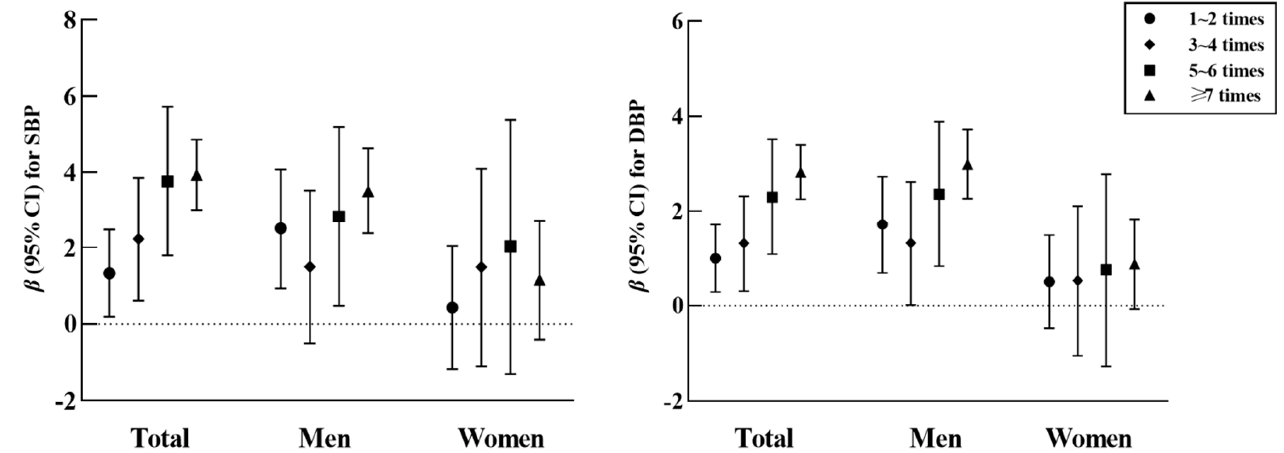
Figure 1. Association between frequency of EAFH and blood pressure. CI , confidence interval; SBP, systemic blood pressure; DBP, diastolic blood pressure; EAFH, eating away from home. Adjusted for age, gender (only for total participants), marital status, education level, average income per month, smoking status, alcohol consumption, physical activity, abundant vegetable and fruit intake, high-fat diet, and family history of hypertension.